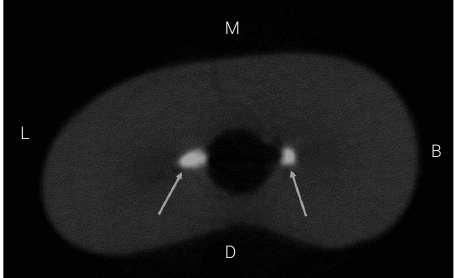
Figure 2. Section of the middle third MN specimen after removal of the filling material, showing remaining material (yellow arrows) in the root canal walls (M-mesial, D-distal, B- buccal and L-lingual